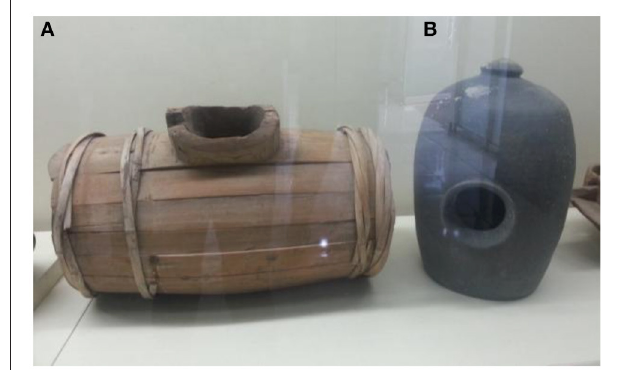
FIGURE 4 | Containers used for the storage of feces (A) and urine (B) called: ojum-janggun and ddung-janggun , respectively, exhibited at Goyang exhibition hall for sanitation in Gyeonggi-Do, Korea (with permission of M.